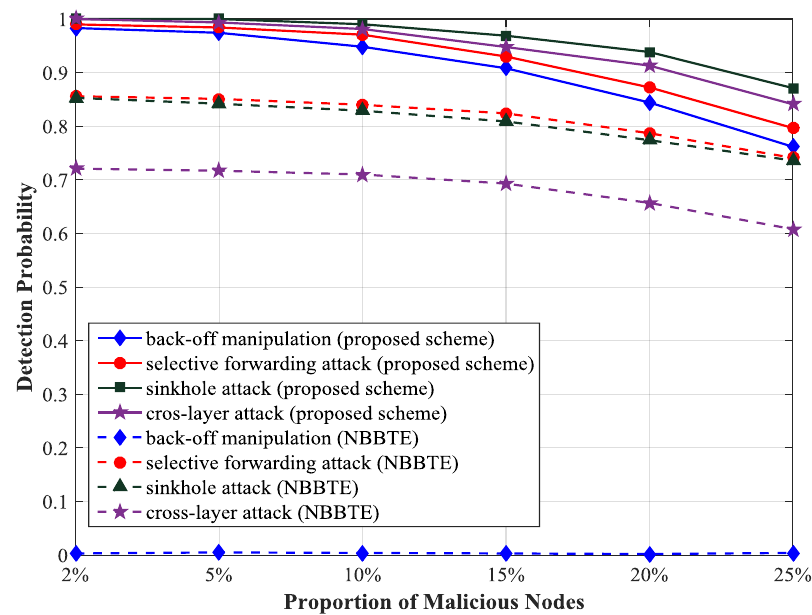
Figure 9. Comparison of the detection probability . NBBTE = Node Behavioral strategies Banding belief theory of the Trust Evaluation algorithm.